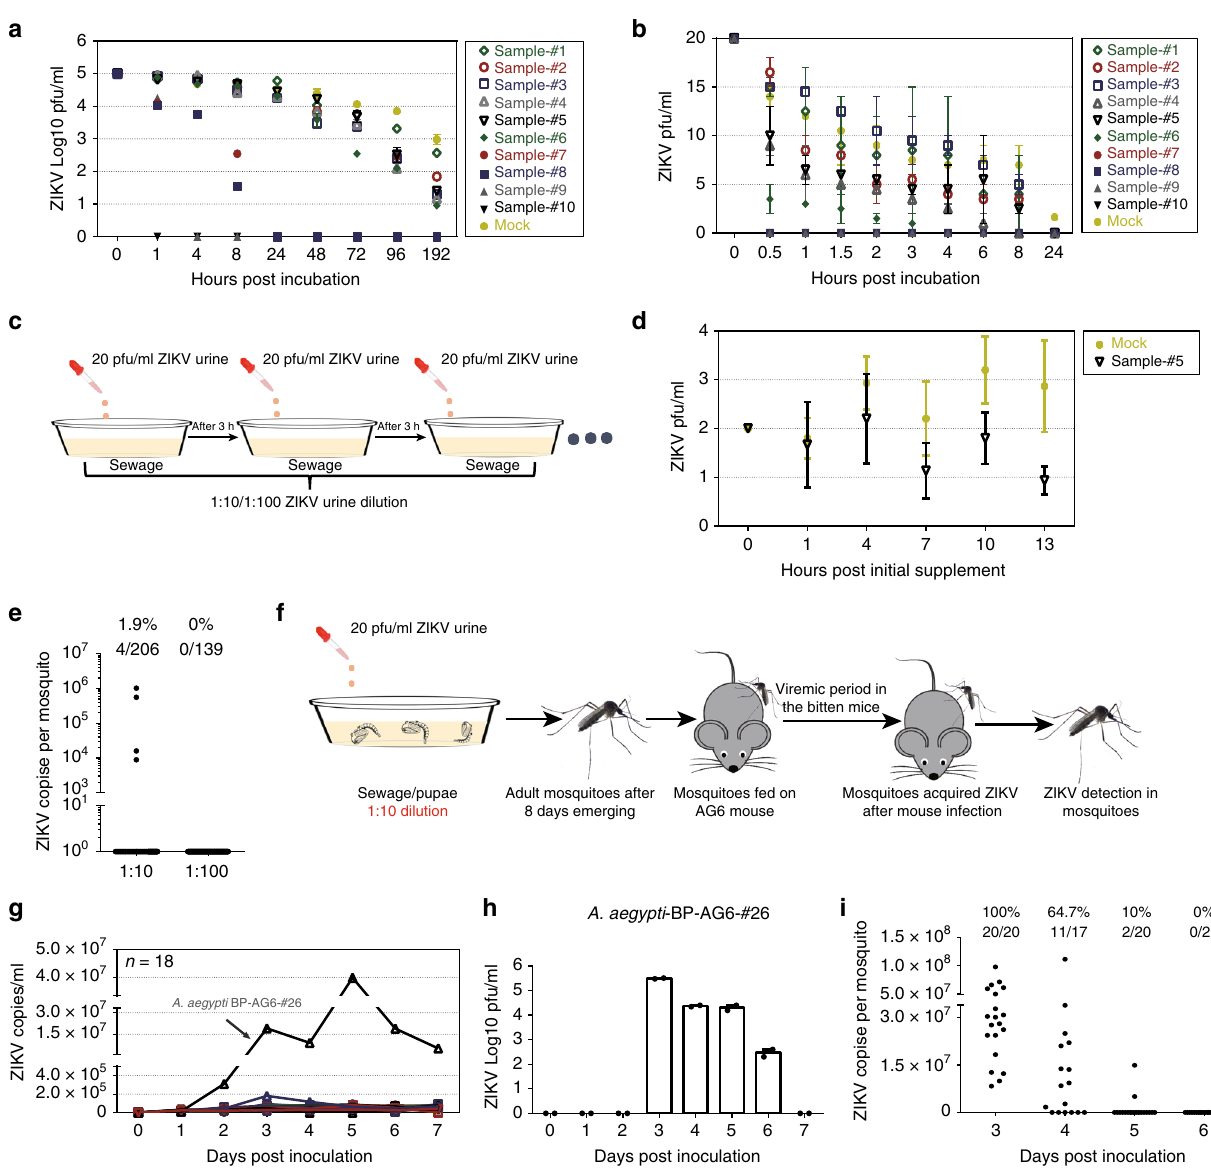
Fig. 3 The fi eld A. aegypti mosquitoes breeding in the infectious sewage transmit Zika virus (ZIKV) to hosts. a , b ZIKV survivability in the sewage samples. The supernatant from ZIKV-infected Vero cells was incubated at 28 °C with the sewage samples or phosphate-buffered saline (PBS) (Mock), with either 1 × 10 5 ( a ) or 20 pfu/ml ( b ) of initial titer. The viral survivability was measured over a time course by a plaque assay. a n = 2 biologically independent samples for sewages and n = 3 for the mock. b n = 2 biologically independent samples. c , d Continuous supplementation of ZIKV in the sewage. c Schematic representation. Either the sewage (Sample #5) or PBS (Mock) was used. d ZIKV survivability in the infectious sewage. The mixtures were maintained at 28 °C for a time course and subsequently subjected to a plaque assay. n = 3 biologically independent samples. a – d The data were repeated by two independent biological replicates with the similar results. e Acquisition of ZIKV infection by the A. aegypti Brazil Paraiba mosquitoes breeding in the infectious sewage. Both ZIKV prevalence and infectivity in A. aegypti . The initial ZIKV urine concentration was 20 pfu/ml. f – i ZIKV is transmissible between AG6 mice and mosquitoes breeding in the infectious sewage. f Schematic representation. g , h ZIKV viremia in the mosquito-bitten AG6 mice. g The presence of ZIKV genome in whole blood was assessed using quantitative PCR (qPCR) detection. n represents the mouse number. h Detection by a plaque assay. n = 2 detection replicates. i Prevalence of ZIKV infection in the mosquitoes fed on a viremic AG6 mouse. e , i The mosquitoes for ZIKV detection by TaqMan qPCR. The number of infected mosquitoes relative to the total number of mosquitoes is shown at the top of each column. One dot represents one mosquito. The percentages are represented as the ratios of mosquito infection. a – h Data are presented as the mean ± SEM. a – i The PRVABC59 strain was used for the incubation. Source data are provided as a Source Data fi